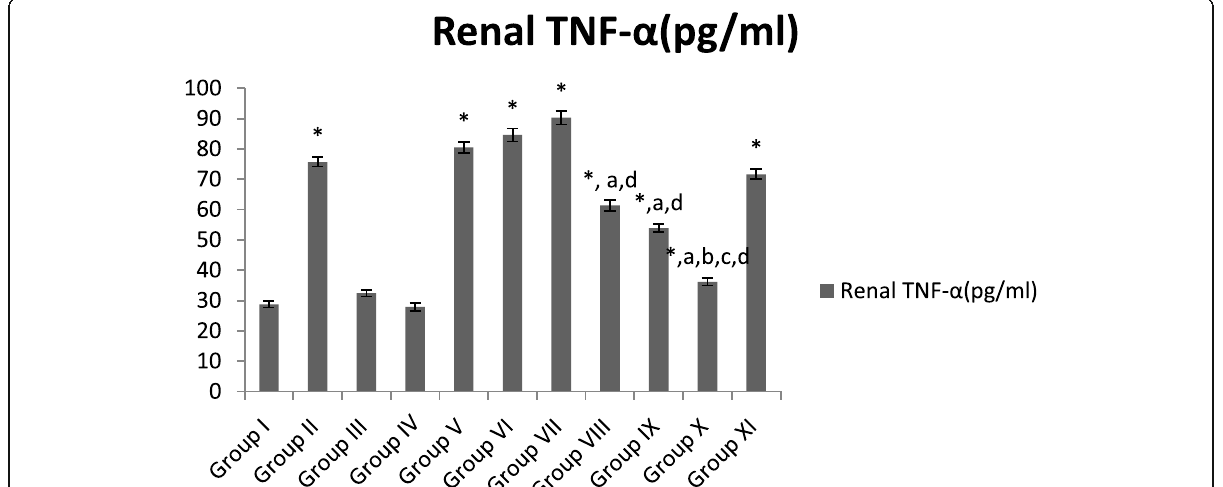
Fig. 7 Graph representing TNF- α levels (pg/ml). All values were represented as mean ± SEM. *= p < 0.001 versus group I (normal control); a = p < 0.001 versus group II (uninephrectomised diabetic control); b = p < 0.005 versus group V (uninephrectomised diabetic rats with oleamide (1mg/ kg) treatment); c = p < 0.005 versus group VI (uninephrectomised diabetic rats with oleamide (2.5mg/kg) treatment); d = p < 0.005 versus group VI (uninephrectomised diabetic rats with oleomide (5mg/kg)